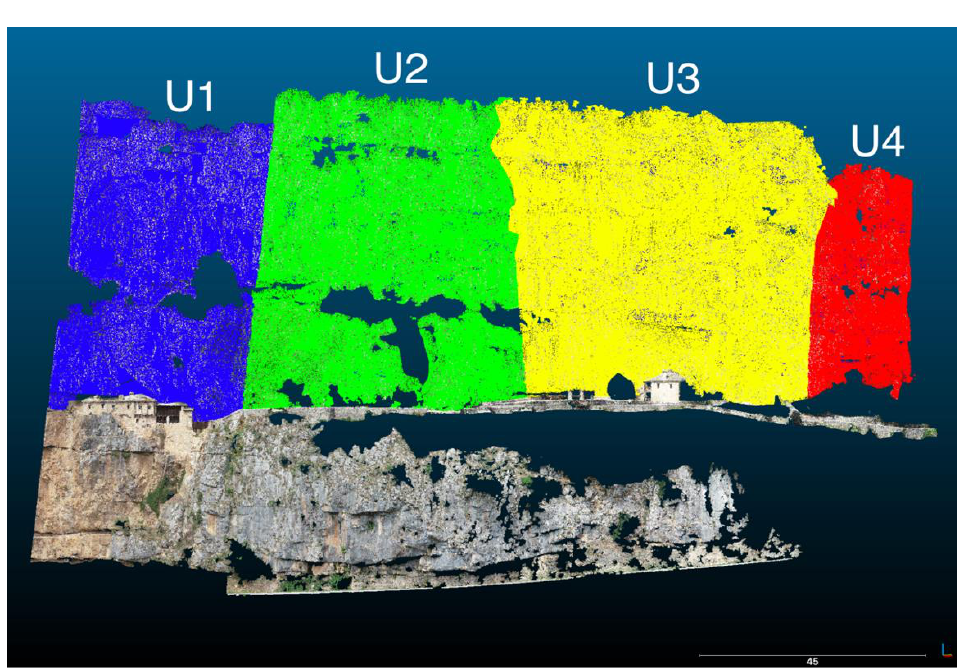
Figure 4. The segmented initial point cloud, in four (4) areas; U1: blue, U2: green, U3: yellow and U4: red.